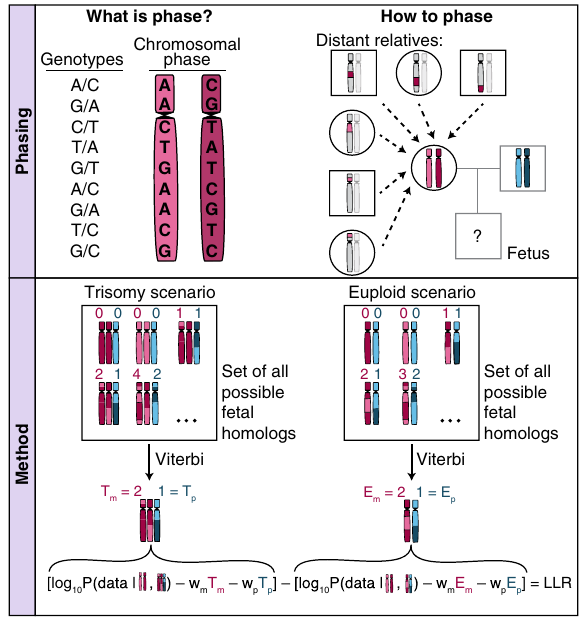
Figure 1. Schematic representation of the role of chromosomal phase in the computation of the discrimination statistic Graphical representation of how chromosomal phase is inferred through relatives on the top and how the space of possible fetal inheritance configurations is explored on the bottom to identify, through the Viterbi algorithm, the two most likely configurations for both the trisomy and the euploid scenario. A log 10 likelihood ratio (LLR) discrimination statistic based on the likelihood of the data and weighed by the number of crossovers and phase switch errors needed to explain the fetal genome is then computed. The weight applied to the number of crossovers and switch errors is akin to assigning a prior over the space of possible fetal inheritance configurations that concentrates the probability towards configurations that can be explained with fewer switches starting from parental